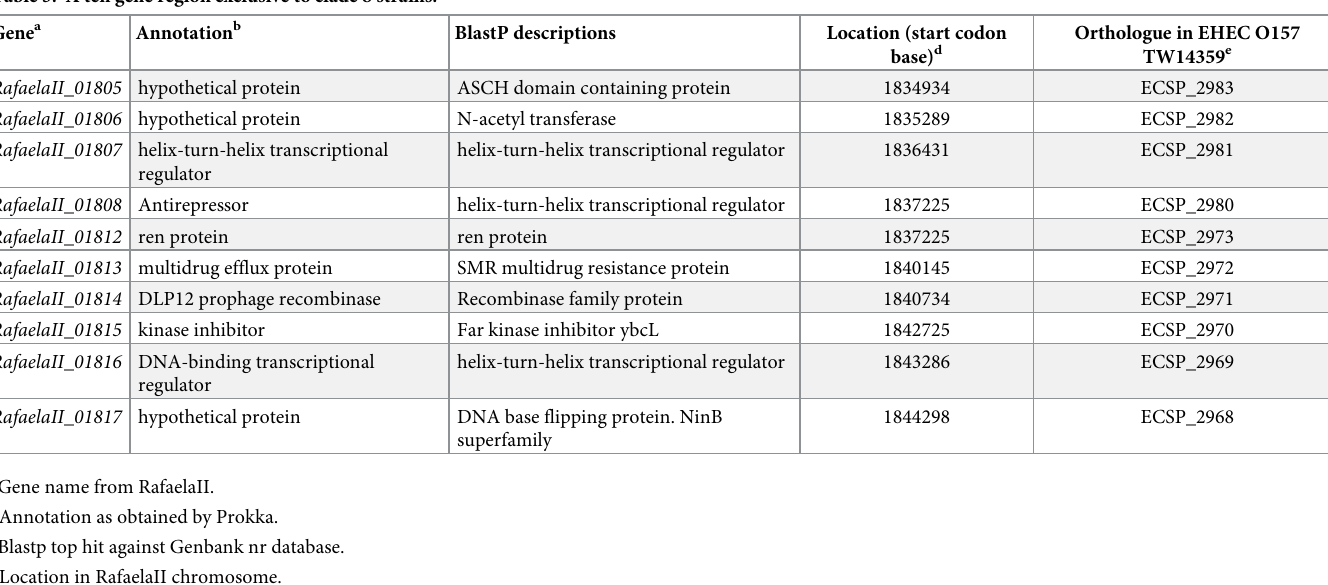
Table 3. A ten gene region exclusive to clade 8